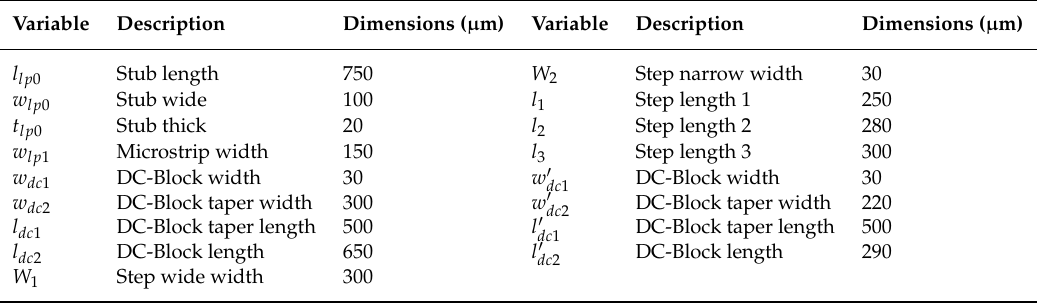
Table 1. Dimensions of the passive circuits of the frequency doubler. See Figure 4, for reference.